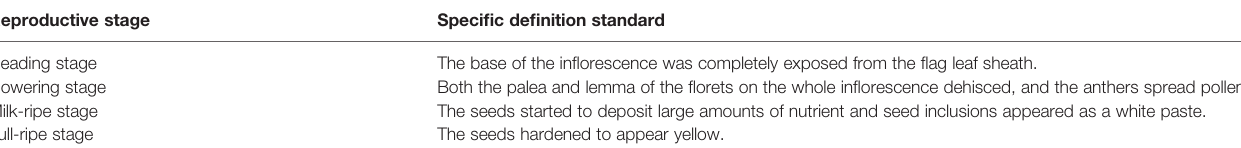
TABLE 1 | Speci fi c de fi nition standard of four reproductive stages in Leymus chinensis . Reproductive stage